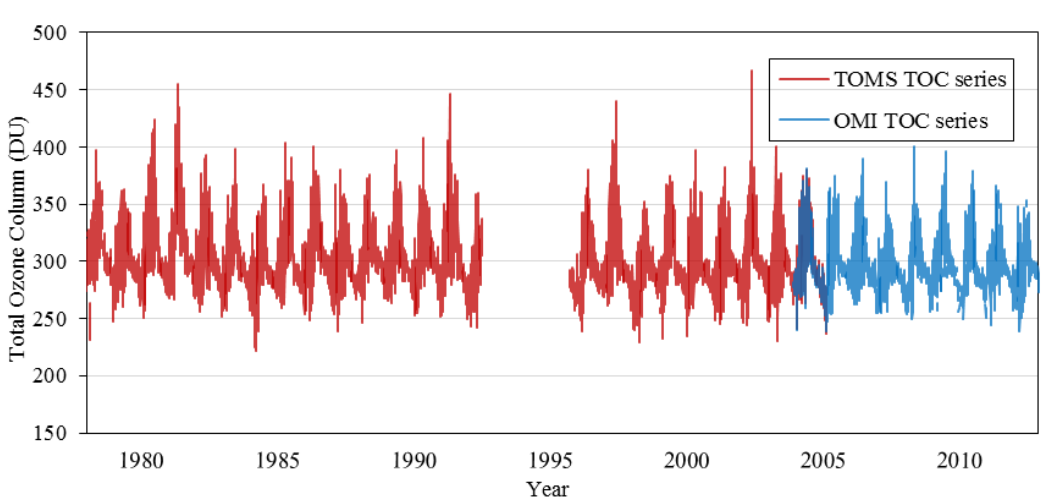
Figure 4. Time series of daily TOC over the Yangtze River Delta (31.5°N) for the period